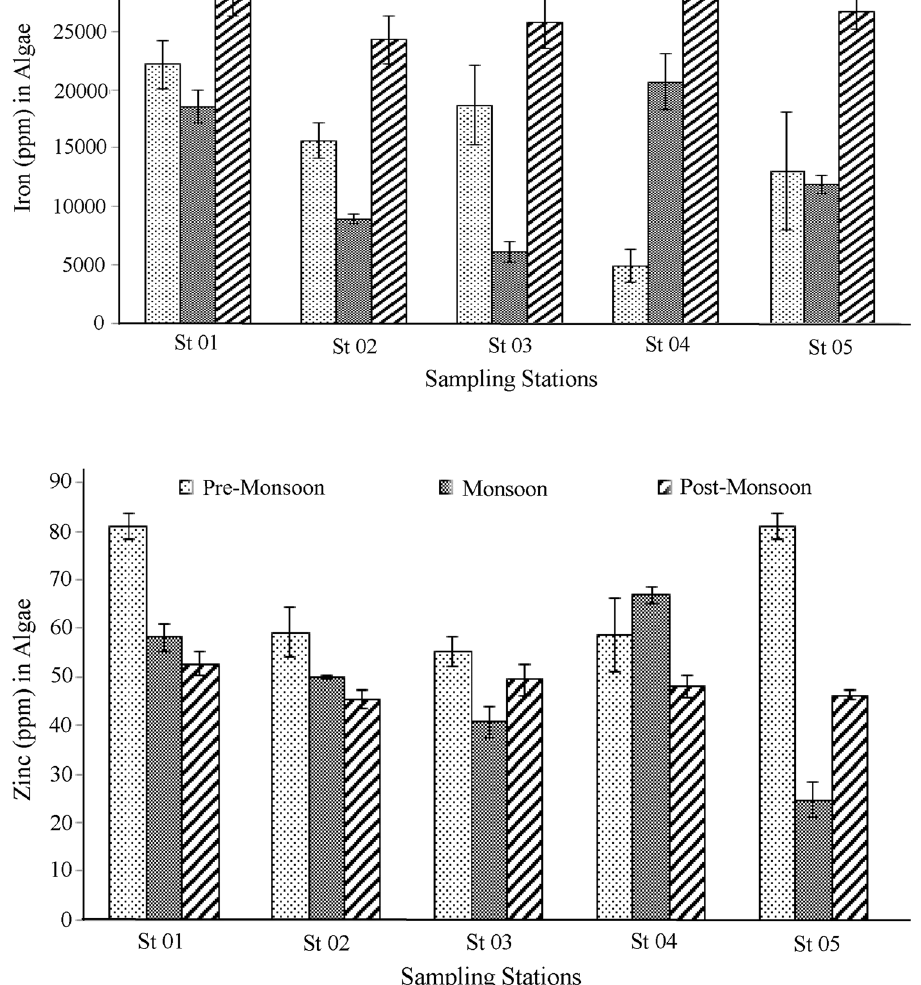
Fig. 9 Algal iron concentra- tion (± SD) variation at different seasons in different stations of Sundarban mangrove estuary